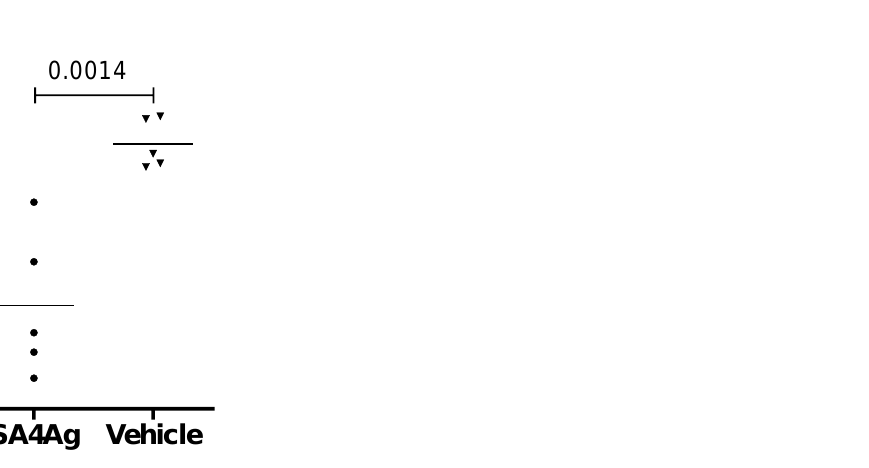
Figure 2. Immunization with SA4Ag reduces bacterial burden in a S. aureus pyelonephritis model. Female CD-1 mice ( n = 5) were vaccinated at weeks 0, 3, and 6, with SA4Ag or with vehicle alone. Two weeks after the final vaccination animals were challenged with ~2 × 10 8 S. aureus Reynolds. Two days post-challenge, the mice were euthanized and kidneys collected. Bacteria in kidneys were enumerated (colony-forming unit [CFU]/kidney). p value was calculated by Student’s t -test.